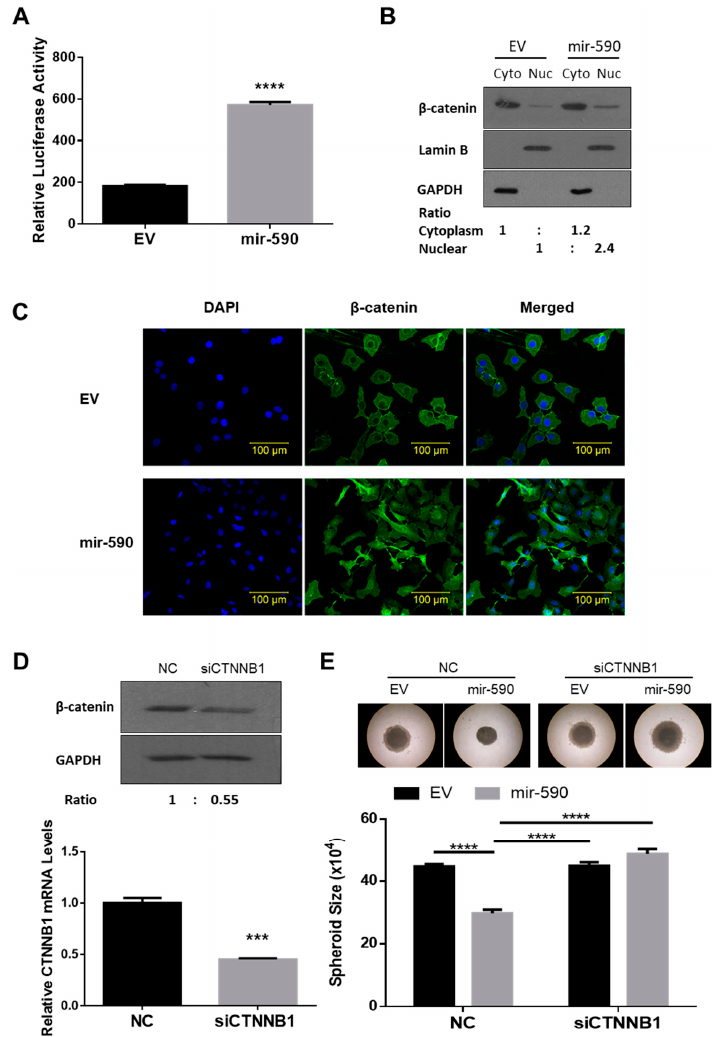
Figure 6. mir-590 enhanced β -catenin signaling. ( A ) A TOPFlash reporter assay was performed in SKOV3.ip1 cells stably transfected with mir-590 or its control empty vector (EV). mir-590 overexpression increased β -catenin transcriptional activity. Data represent the mean ± SEM ( n = 3). ( B ) Cytosolic (Cyto) and nuclear (Nuc) fractions were prepared from EV and mir-590-overexpressing SKOV3.ip1 cells, and Western blotting was performed. mir-590 cells exhibited higher β -catenin in their nucleus. The densitometry readings of cytoplasmic and nuclear fractions were normalized to their corresponding GAPDH and Lamin B levels, respectively. ( C ) Immunofluorescence staining of β -catenin showed that SKOV3.ip1 cells stably overexpressing mir-590 had strong β -catenin signals in their nucleus. ( D ) Knockdown of CTNNB1 using siRNA reduced the mRNA and protein levels of β -catenin. ( E ) Silencing of CTNNB1 blocked the effect of mir-590 on spheroid formation in SKOV3.ip1 cells. Data represent the mean ± SEM ( n = 10). Statistical analyses were performed using Student’s t -test (A and D), or two-way ANOVA/Student–Newman–Keuls test (E). *** p < 0.001, **** p <